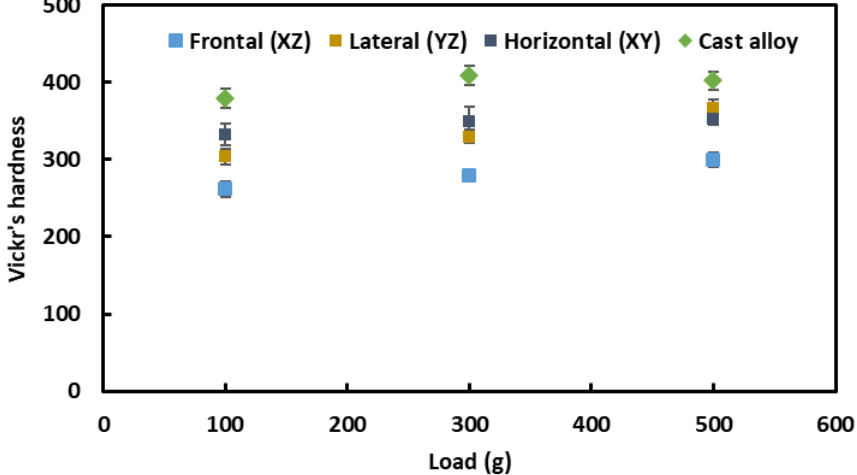
Figure 7. Vickers’s hardness of L-PBF and cast Inconel 718 alloy.